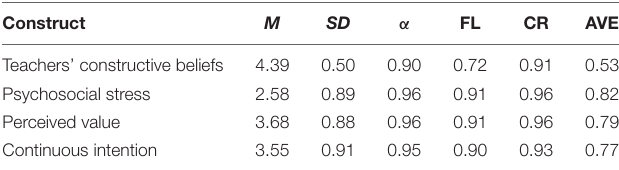
TABLE 2 | Reliability and validity analysis.